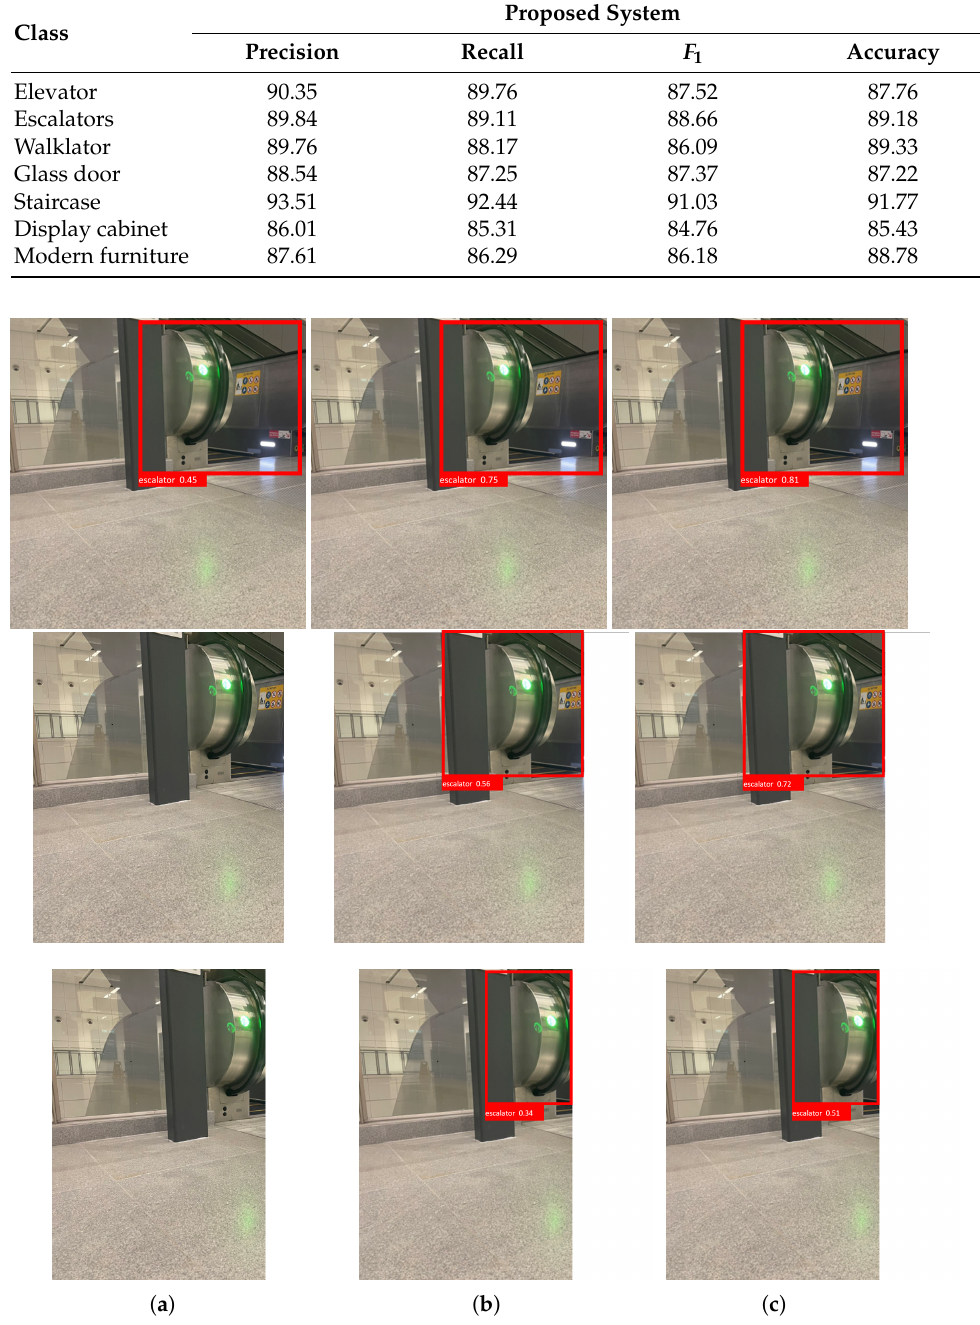
Figure 4. Comparison analysis results of the context-aware object detection algorithm and conven- tional object detection scheme for the escalator and glass door: ( a ) Yolo V4; ( b ) Faster RCNN ResNet 50; ( c ) Proposed system. From top to bottom, the occlusion conditions are shown from low, medium, and high levels. Table 2. Comparison with conventional